Question: What visual encoding does this figure use to show its data?
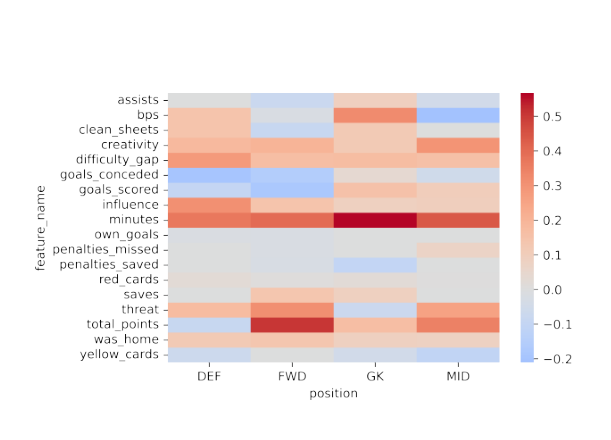
Answer: heatmap